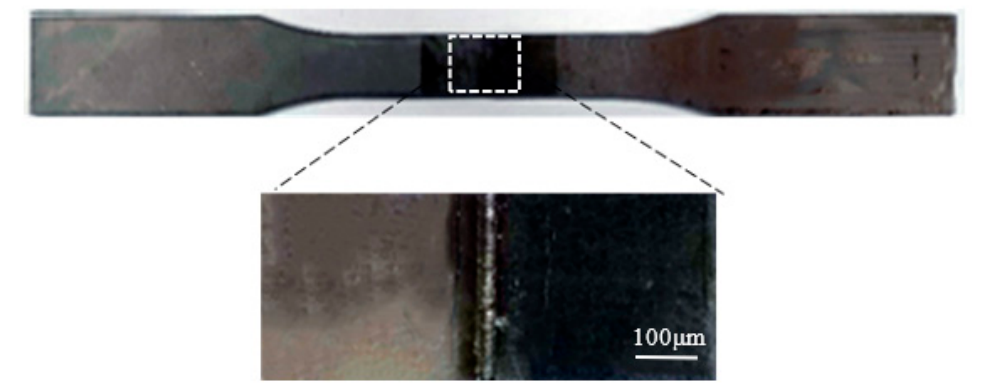
Figure 3. DP590-304 (preset nickel coating) tensile sample.